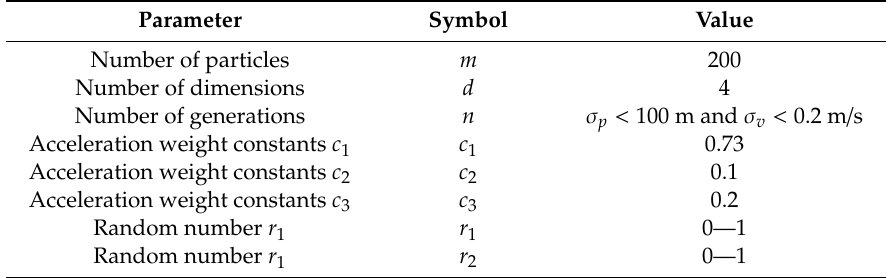
Table 1. Particle swarm optimization parameters used to find the optimal initial position and velocity of target.